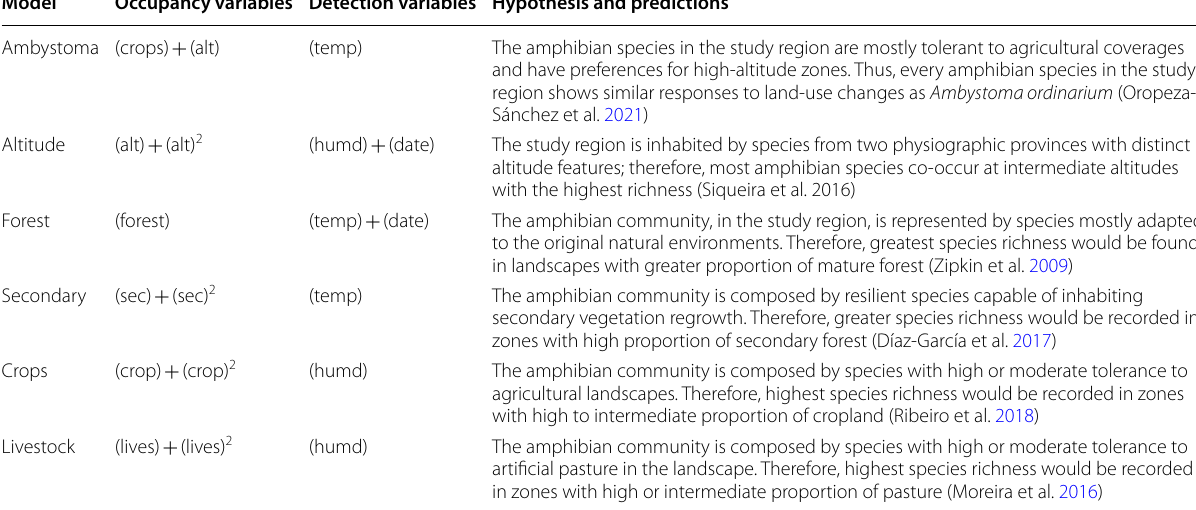
Table 1 Multi‑species occupancy models developed for explaining occupancy patterns of amphibians in Northwest Michoacán riparian zones